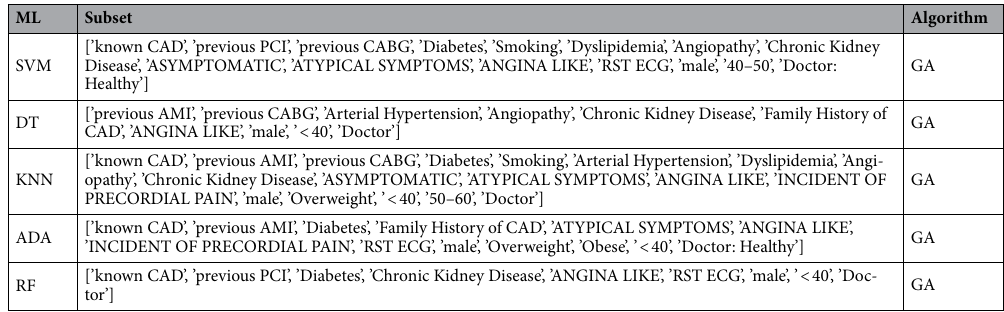
ML Subset Algorithm